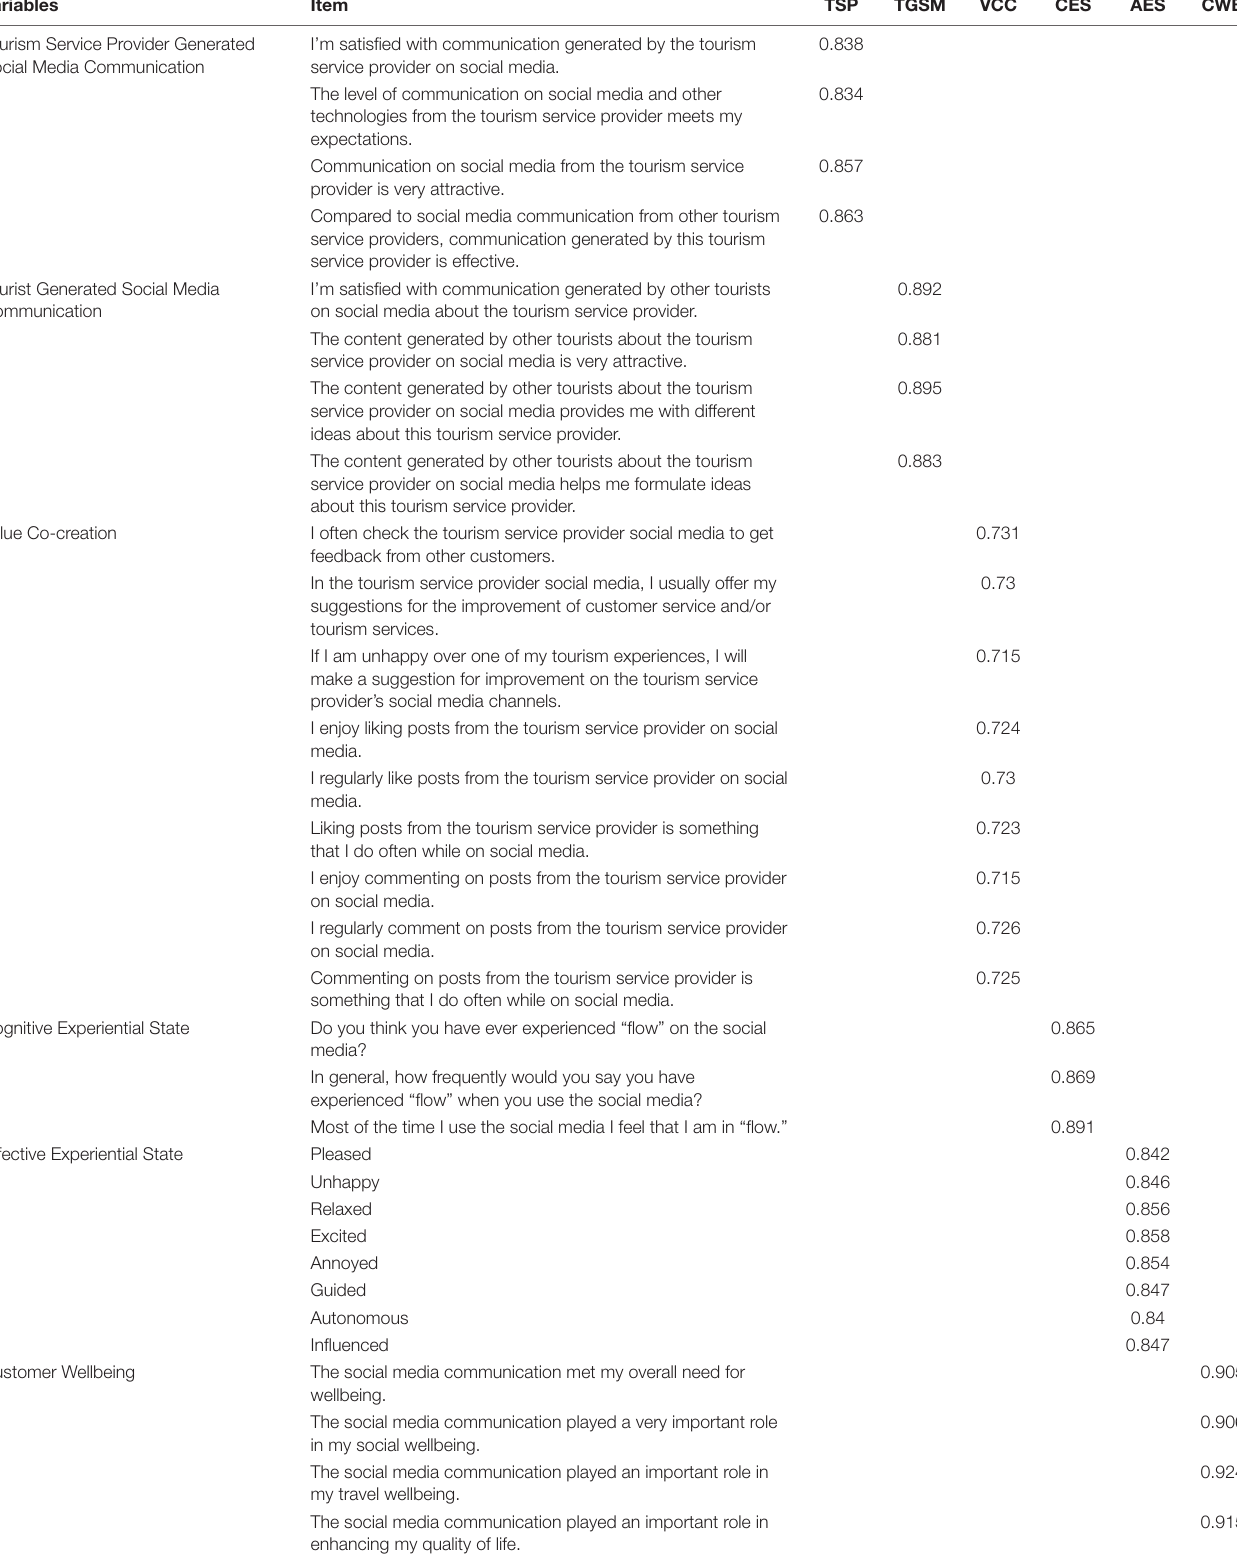
TABLE 1 | Standardized factor